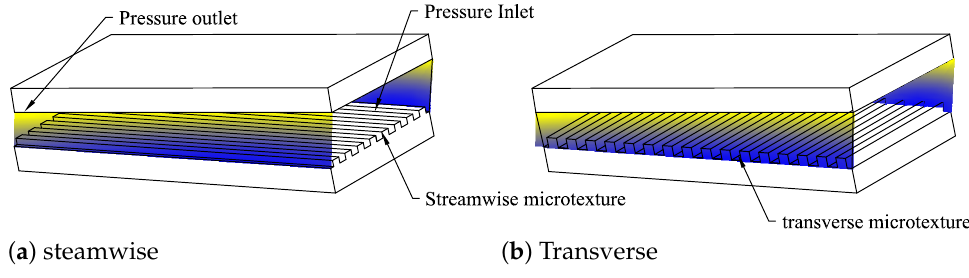
Figure 7. Schematic diagram of slider bearing